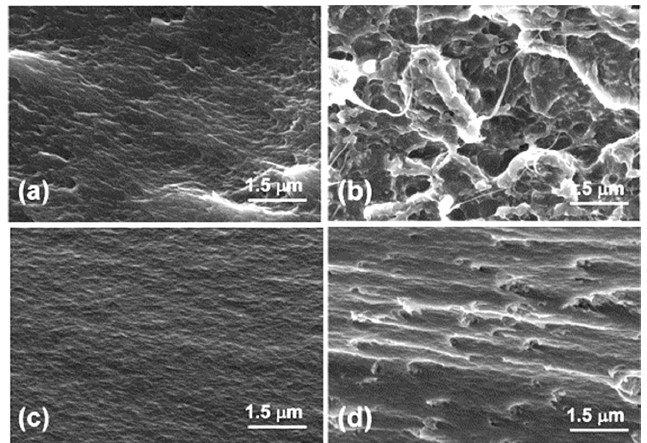
Figure 4. Cross-section morphology of ( a ) TPEQ-ODPA; ( b ) TPEQ-ODPA-S; ( c ) PMDA-ODA; and ( d ) PMDA-ODA-S.